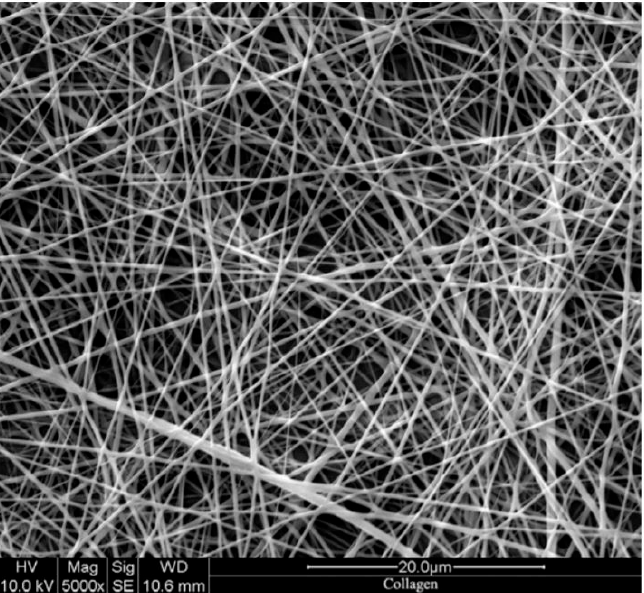
Figure 16. Scanning electron microscopy image of an electrospun polymer: a poly(acrylonitrile) non-woven nanofiber mat produced by electrospinning (adapted with permission from [221]).